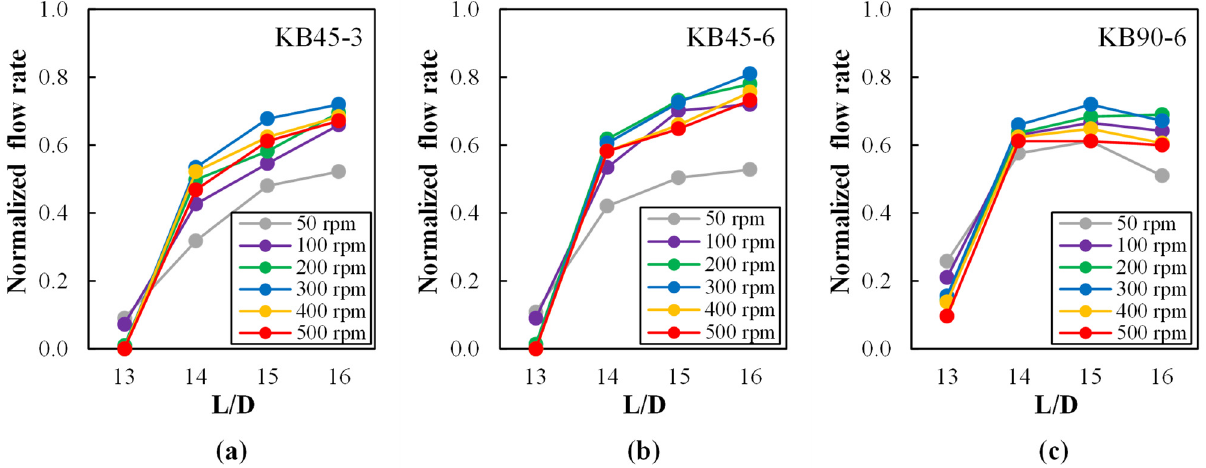
Figure 3. Normalized flow rate at ports L/D = 13, 14, 15, and 16 along the mixing zone as a function of screw speed (50 to 500 rpm) for each kneading block: ( a ) KB45-3, ( b ) KB45-6 and ( c ) KB90-6. The normalized flow rate is a direct indication of the local pressure inside the screw channel.